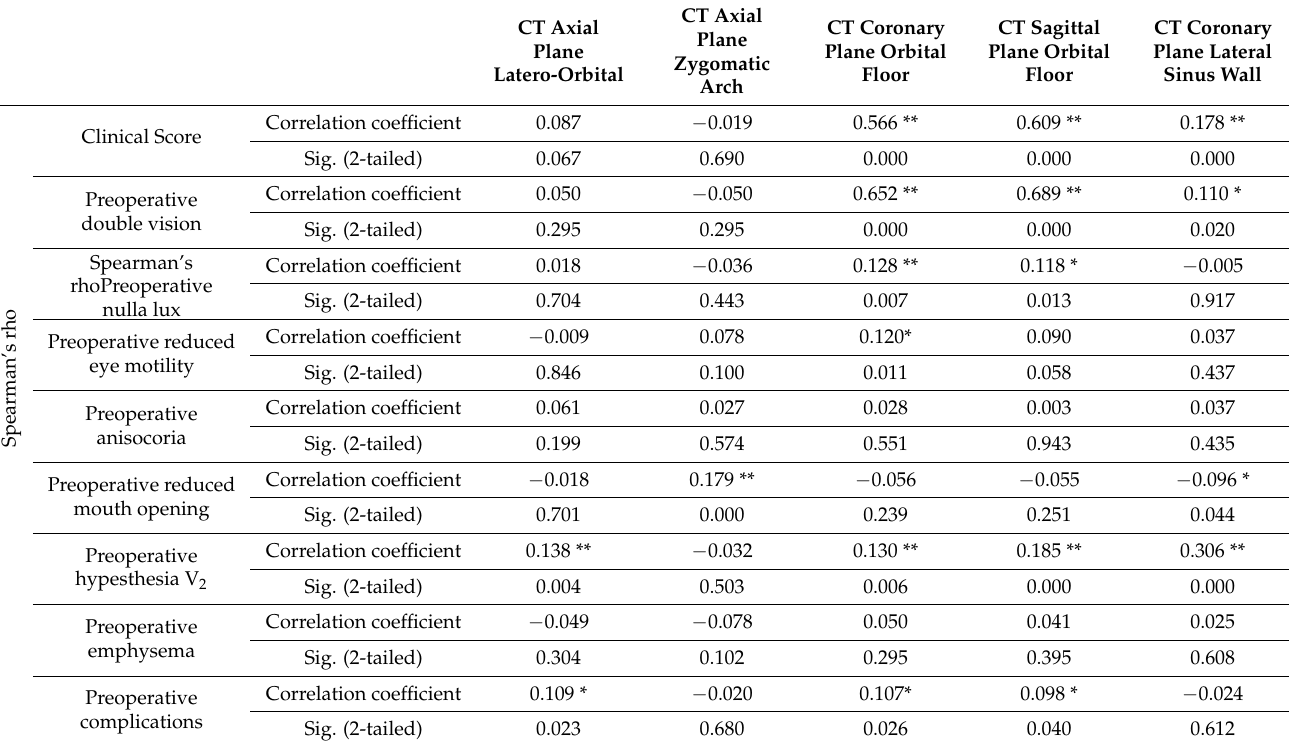
Table 8. Computed bivariate Spearman rank correlation coefficients ( ρ ) of Clinical Score and preop- erative symptoms with degree of fracture dislocation in corresponding CT scans in patients with isolated unilateral zygomatico-orbital